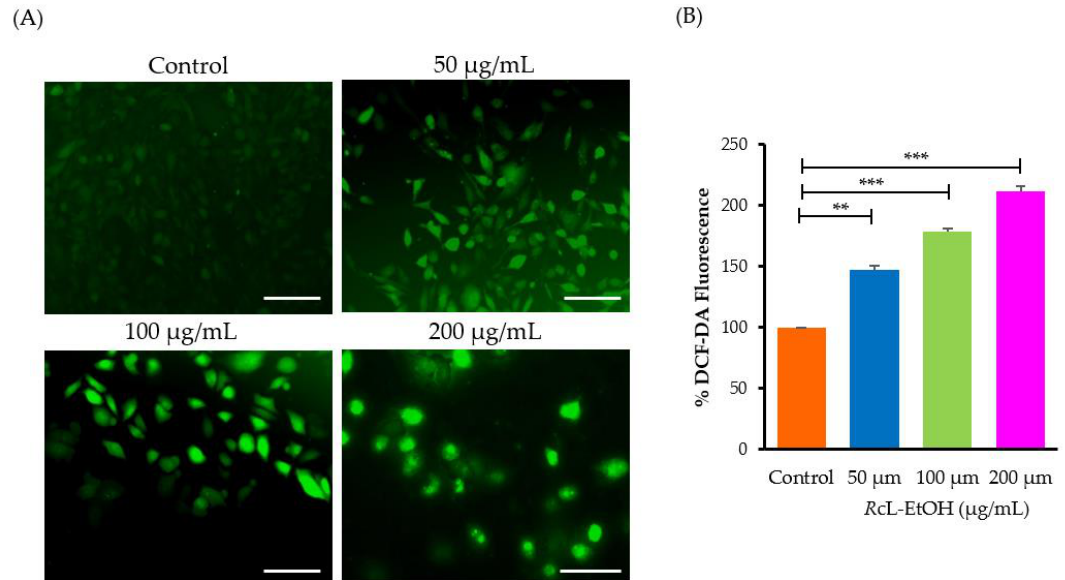
Figure 5. ( A ) Photomicrographs elucidating augmented ROS levels within A549 cells post-treatment with different concentrations of R cL-EtOH and subsequent staining with DCFH-DA. Scale bar = 100 µm. ( B ) Quantitative evaluation of fluorescence intensity. ** p < 0.01, *** p < 0.001 vs. control.